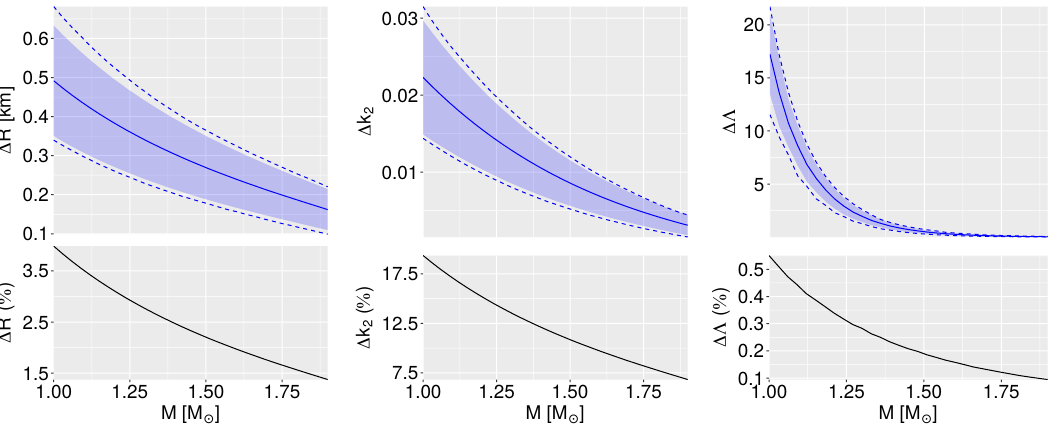
Figure 6. Prediction difference in NS radius (left), Love number k 2 (center), and Λ (right). Top panels: Mean difference values (solid line), ∆ A = 1 number of models, ∆ A ± 2 σ (filled region), and maximum/minimum ∆ A values (dashed lines); Bottom panels: Relative difference (%), defined by ∆ A = 100 × ( 1 where ¯ A = ( ¯ A (cid:101) + ¯ A µ )